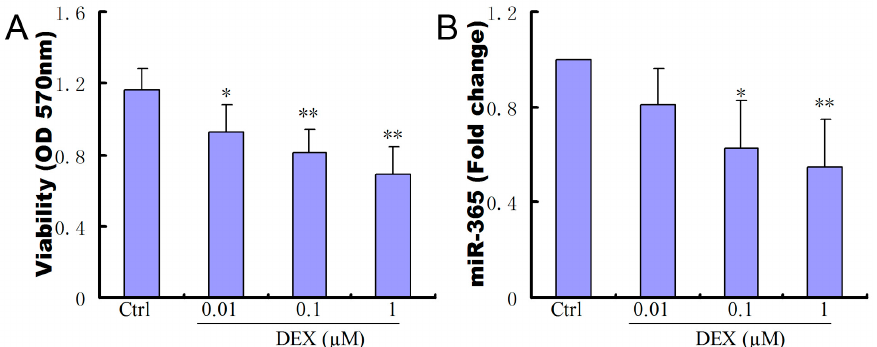
Figure 1. Dexamethasone (DEX) inhibited cell viability and decreased the expression of miR-365 in MC3T3-E1 cells. ( A ) DEX inhibited osteoblast cell viability in a dosage dependent fashion ( n = 6); ( B )